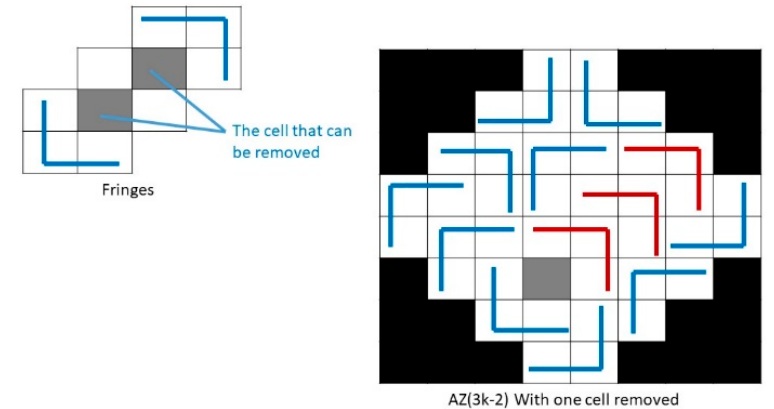
Figure 9. Image Argument for Lemma 6.